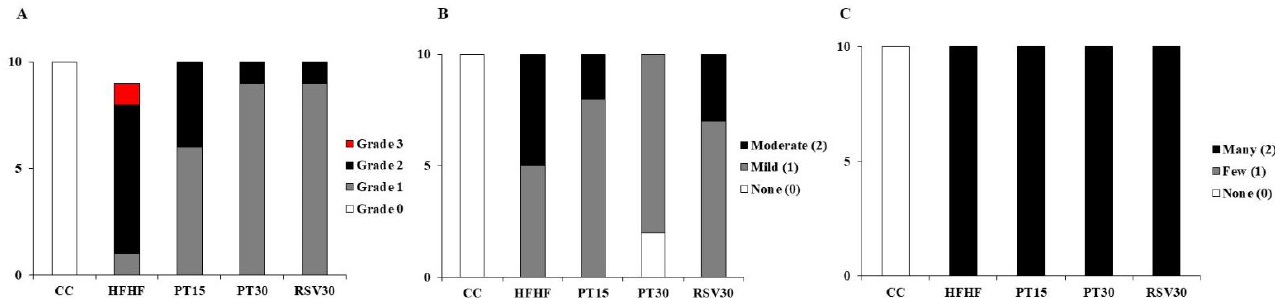
Figure 1. Number of rats showing no steatosis, grade 1, 2 or 3 steatosis ( A ), none, mild or moderate inflammation ( B ) and none, few or many areas of ballooning ( C ) in rats fed with a control diet (CC), a high-fat high-fructose diet (HFHF), a high-fat-high-fructose diet and pterostilbene at a dose of 15 mg/kg/d (PT15), a high-fat high-fructose diet and pterostilbene at a dose of 30 mg/kg/d (PT30) or a high-fat high-fructose diet and resveratrol at a dose of 30 mg/kg/d (RSV30). In the HFHF group, steatosis was analysed in 9 animals.